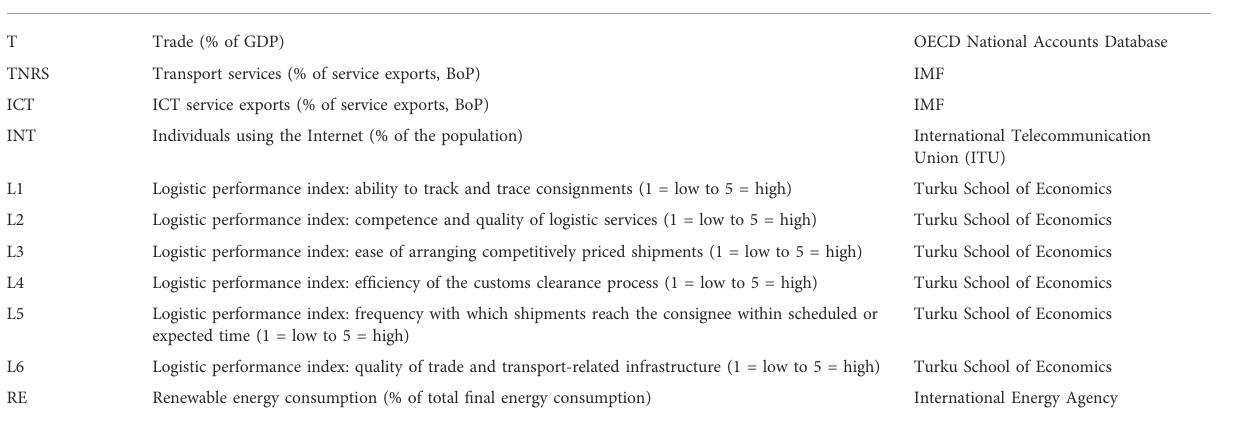
TABLE 1 Source of data (period of review 2007 –